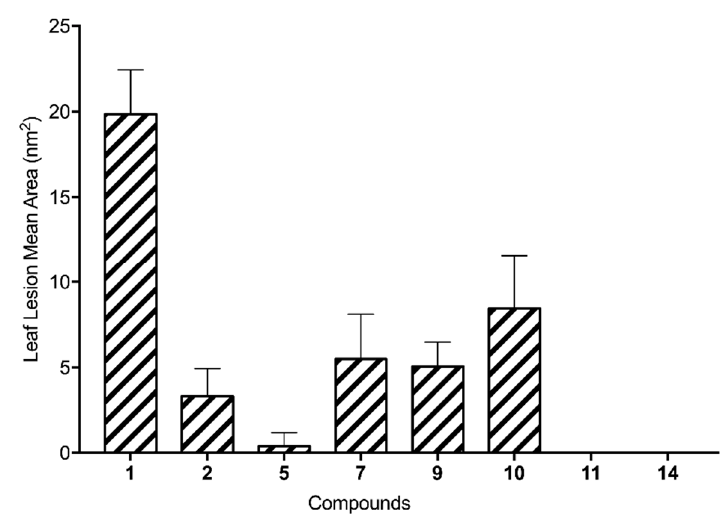
Figure 3. Results of the leaf puncture bioassay on buffelgrass ( Cenchrus ciliaris ) at a concentration of 10 − 3 M for the hemisynthetic derivatives ( 7 , 9 , 10 , 11 , and 14 ) and the natural compounds ( 1 , 2, and 5 ).